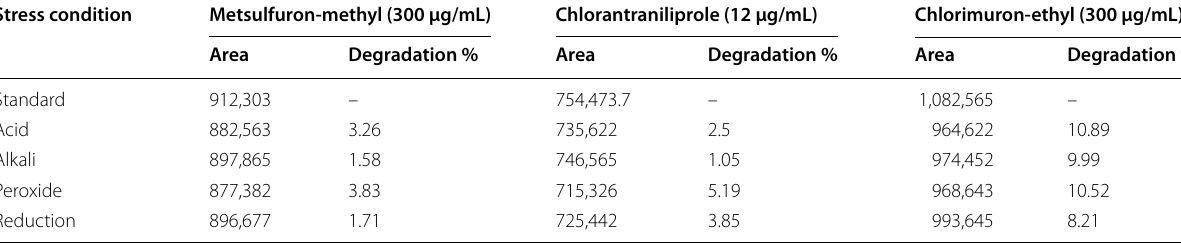
Table 6 Results of forced degradation studies for the analytes Stress